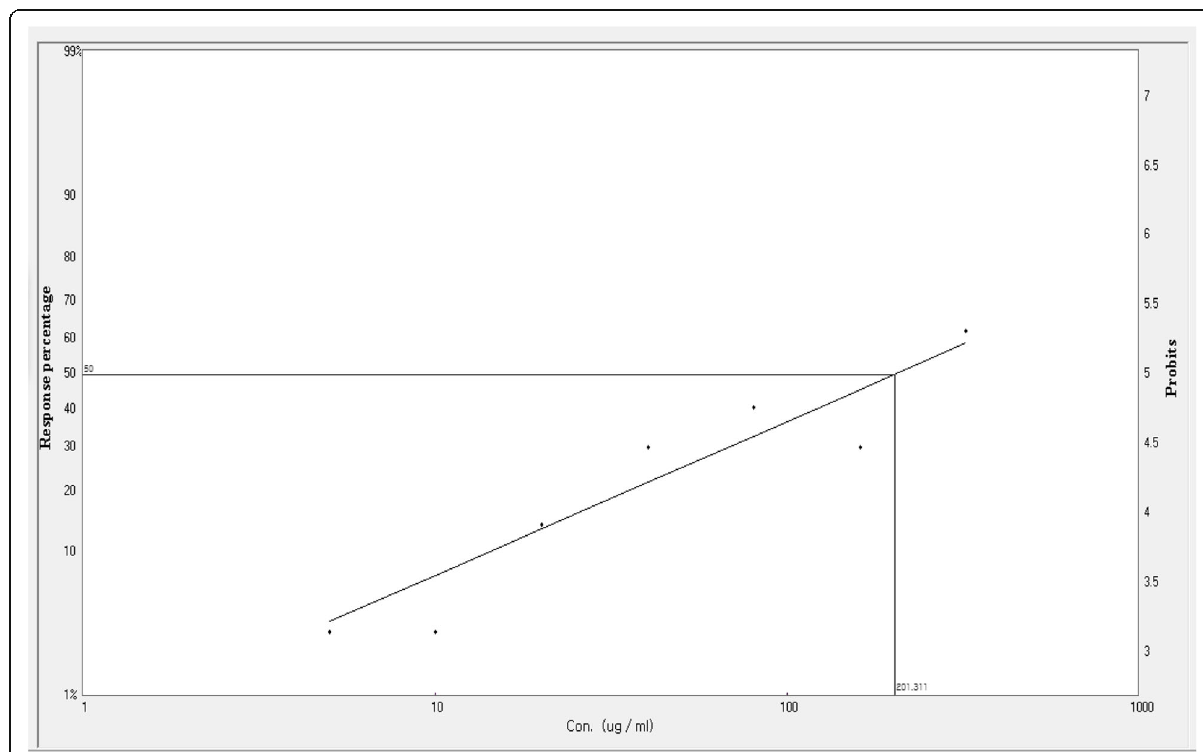
Fig. 5 LC 50 of the leaf extract